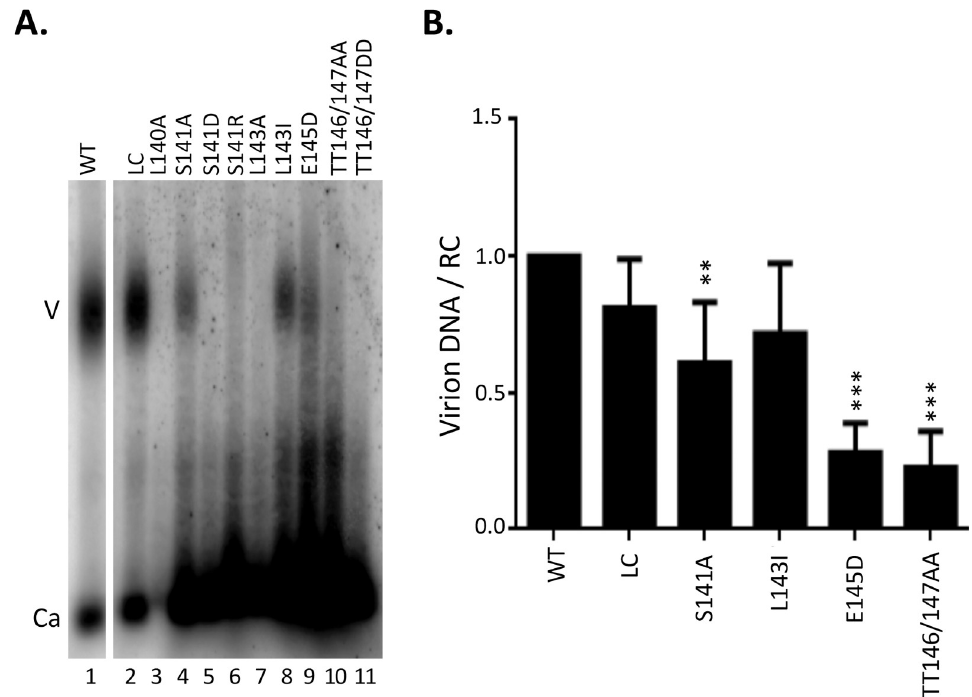
Fig 6. Effect of linker mutations on virion secretion. HepG2 were co-transfected with indicated HBc expression constructs and the HBV genomic construct defective in HBc expression and the culture supernatant was collected seven days post-transfection. A. Concentrated culture supernatant was resolved by agarose gel electrophoresis and transferred to nitrocellulose membrane. HBV DNA in virions and naked capsids were detected by using the HBV DNA probe. B. DNA virion secretion efficiency was determined by normalizing levels of virion DNA to cytoplasmic RC DNA levels (as shown in Fig 5). The efficiency from WT was set to 1.0. V, virion; Ca, capsid. �� , P < 0.01; ��� , P < 0.001.